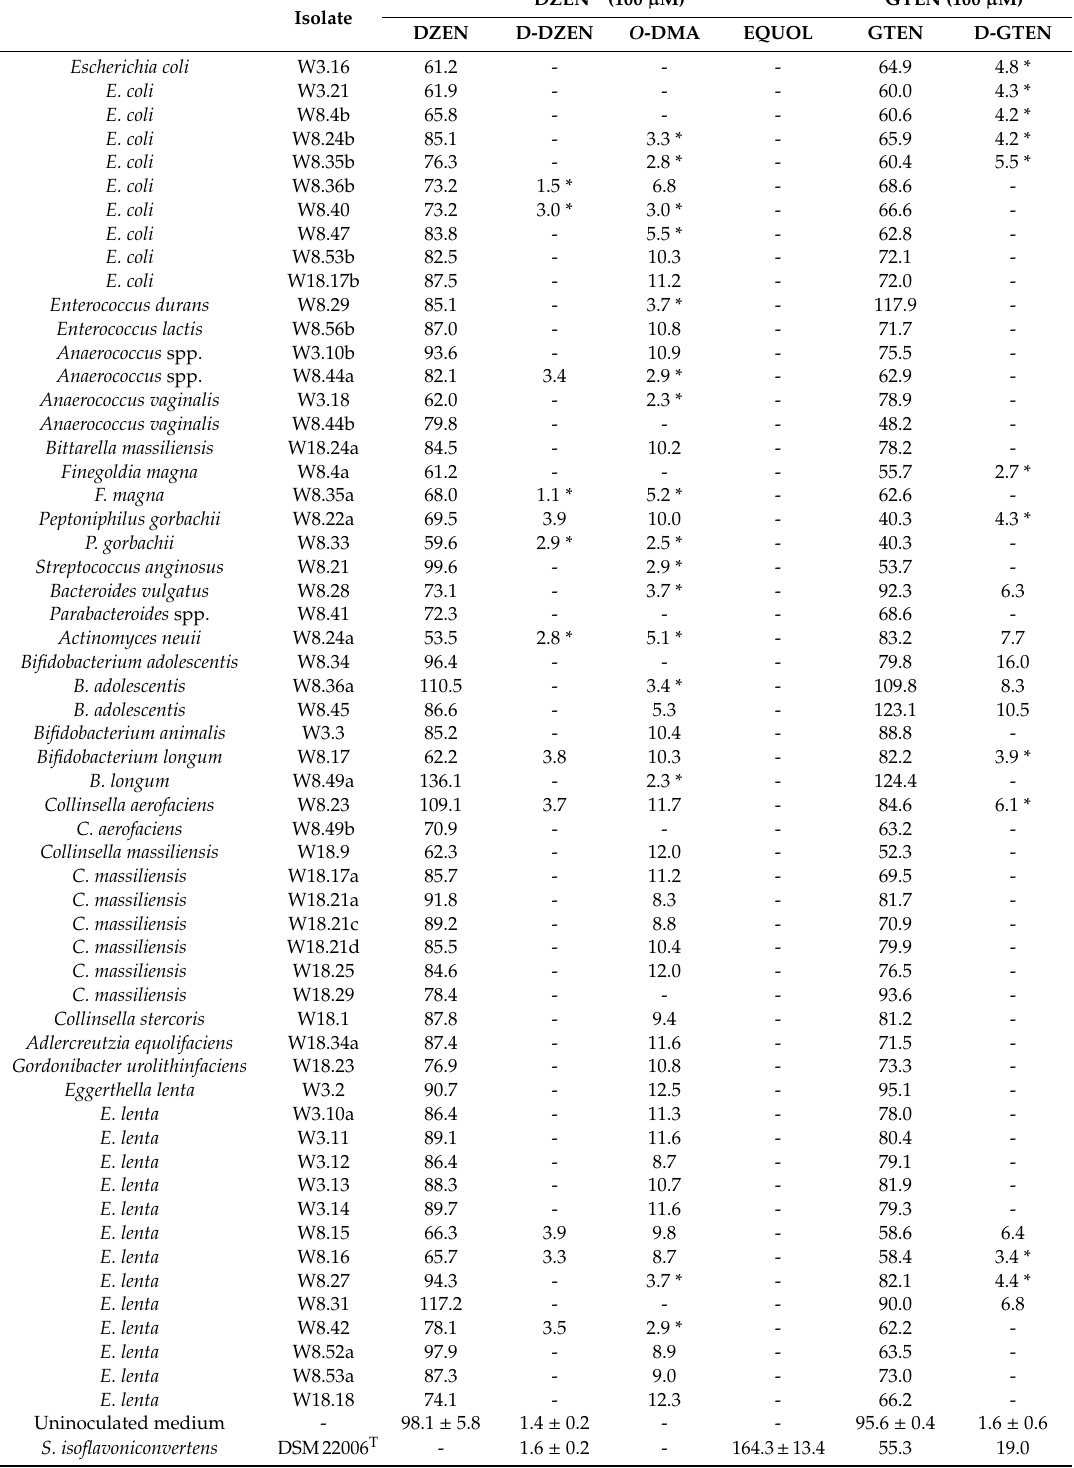
Table 3. Metabolism of daidzein and genistein by isolates and controls and the metabolites detected.